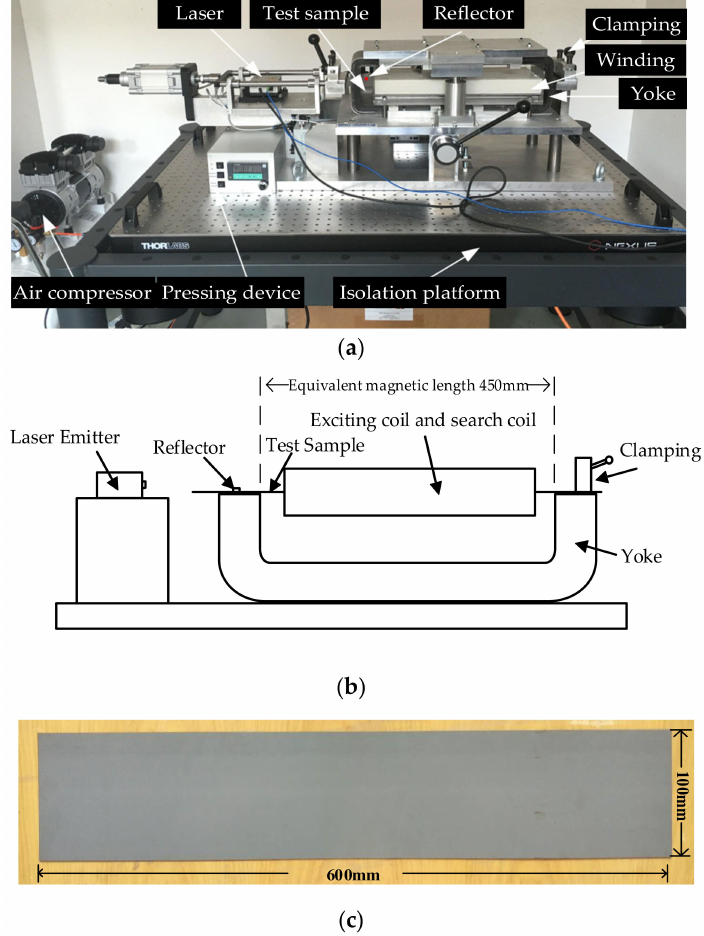
Figure 1. Laser-based measuring system of magnetostrictive properties: ( a ) Practical device; ( b ) diagrammatic sketch of measuring structure; ( c ) test